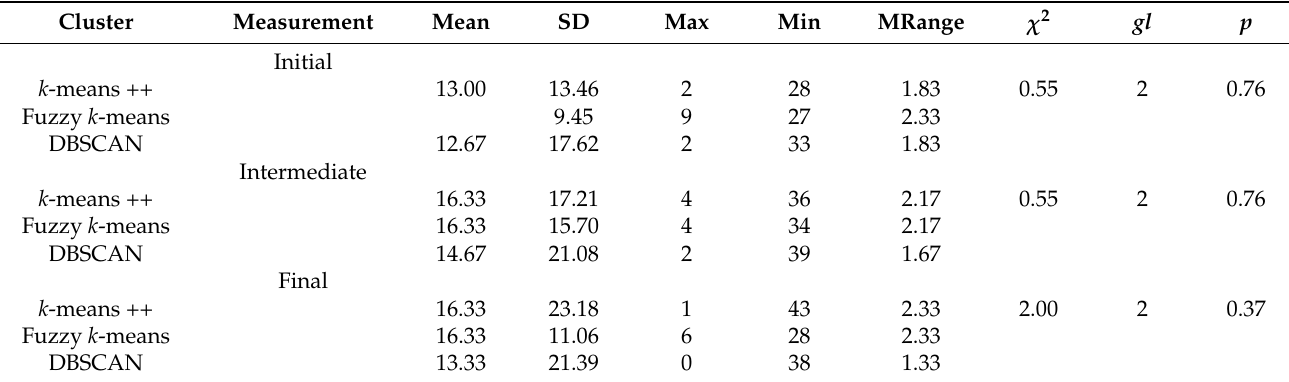
Table 4. Analysis of the differences with the Friedman test for k-dependent samples between the results of grouping students in the three clusters in the initial, intermediate, and final